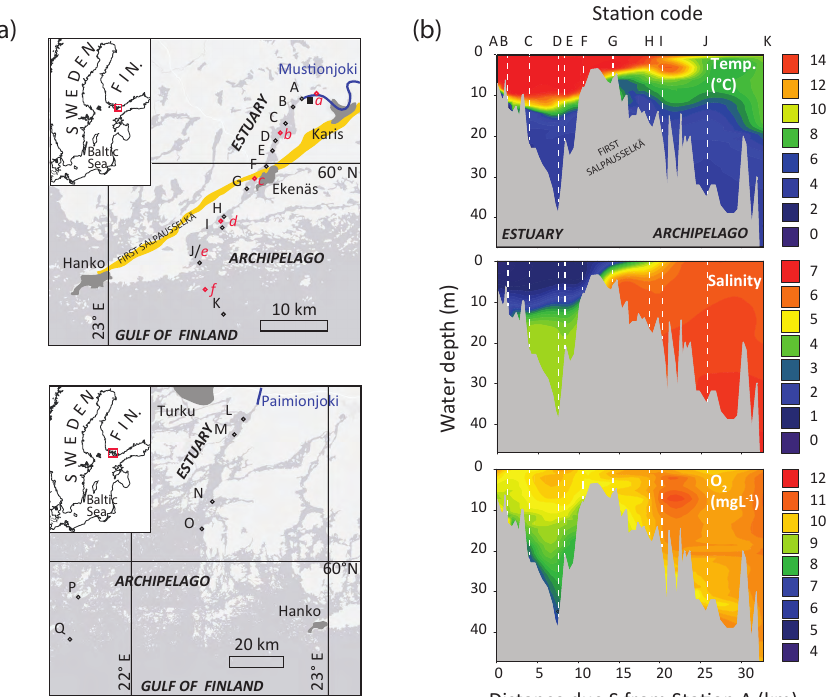
Figure 1. (a) Location of the Mustionjoki estuary transect (top) and the Paimionjoki estuary transect (bottom). In both systems, point-source river inputs discharge into a channel-like estuary, which in turn connects into the archipelago coastline of the Gulf of Finland, northern Baltic Sea. Sediment and water column sampling locations are indicated A–Q (of which L–Q were first reported in Virtasalo et al., 2005). Dissolved organic matter (DOM) sampling locations (Asmala et al., 2014, 2016) are indicated by the red lower-case labels a–f. The location of the Åminnefors blast furnace is indicated by the black square. The First Salpausselkä ice-marginal formation is indicated in yellow. (b) Water column characteristics of the Mustionjoki transect during sampling in June 2015. 2-D contour plots were generated by extrapolation between the measured profiles at Stations A–K using SigmaPlot ™ software. Distances along transect are reported as distance directly due south (S) from Station A at the Mustionjoki river